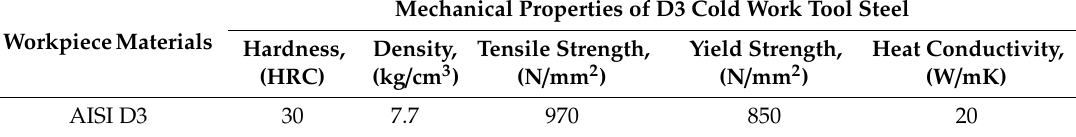
Table 2 AISI D3 cold work tool steel mechanical properties.